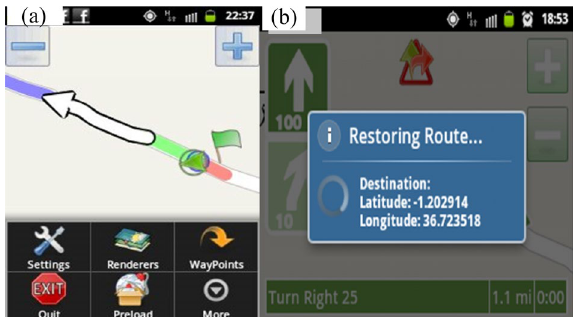
Fig. 4 Real-time route navigation. a The white arrow showing distance to destination and b Display of route lost and hence application re-routing the PVC to destination